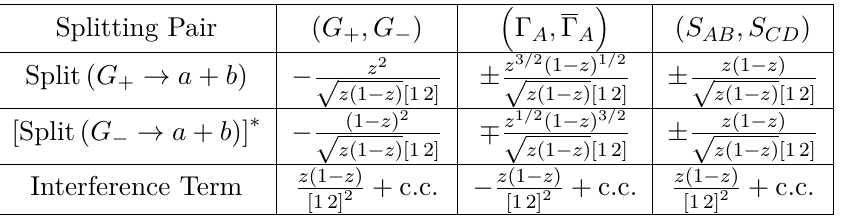
Table 1. Splitting amplitudes for gluons, fermions and scalars, and their associated interference terms. In N = 4 SYM, the appropriately weighted sum over the supermultiplet leads to a vanishing spin interference effect at leading